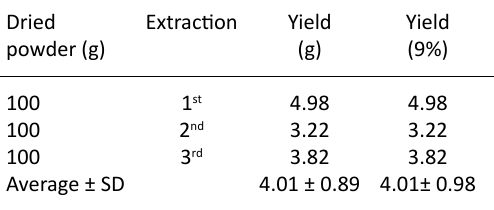
table 1 . Extraction yield of the Cucurma xanthorrhiza Roxb.